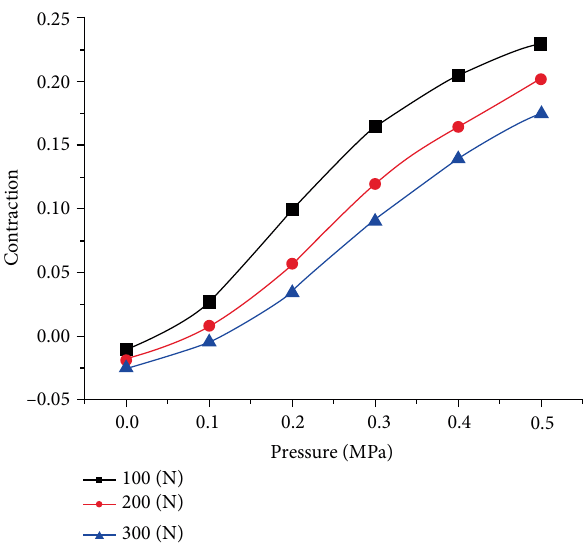
Figure 10: Force of PAMs with different initial muscle diameters under the pressure of 0.3 MPa.